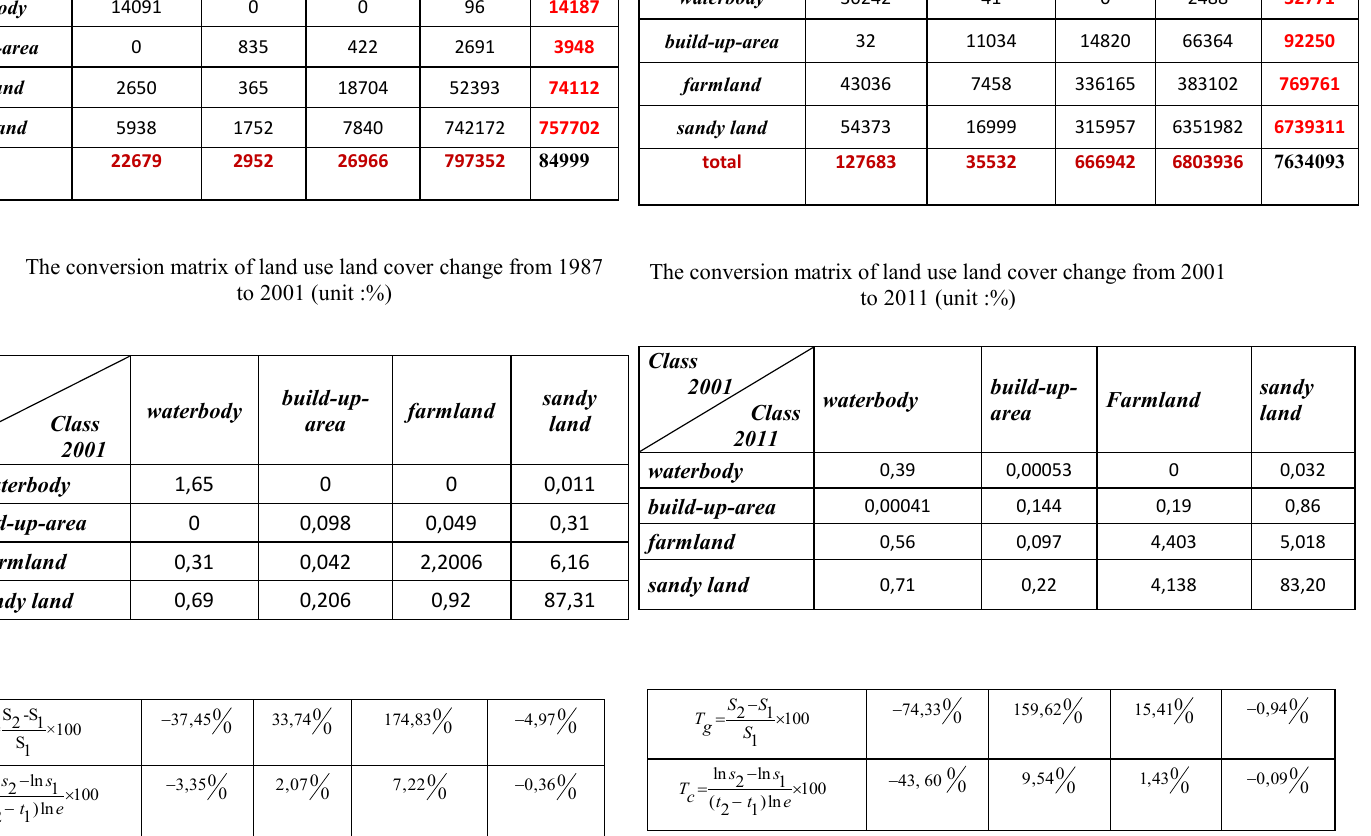
Table 1: Quantitative evaluation of land use changes during the period from 1987 to 2001.